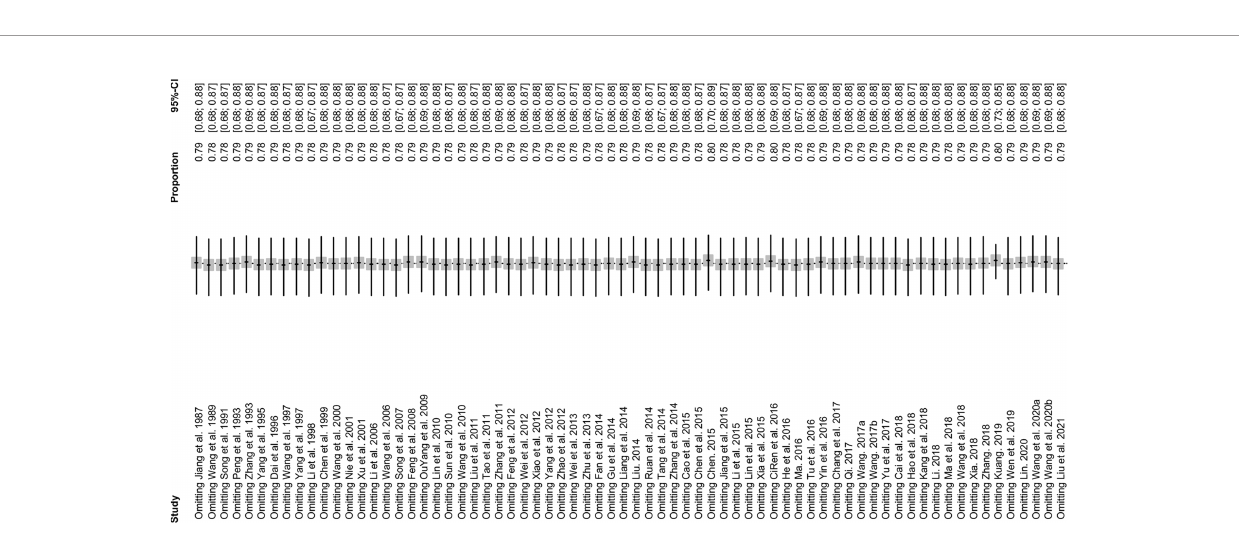
FIGURE 4 | Sensitivity analysis. After removing one study at a time, the remaining studies were re-combined using a random-effects model to verify the impact of a single study on the overall results.